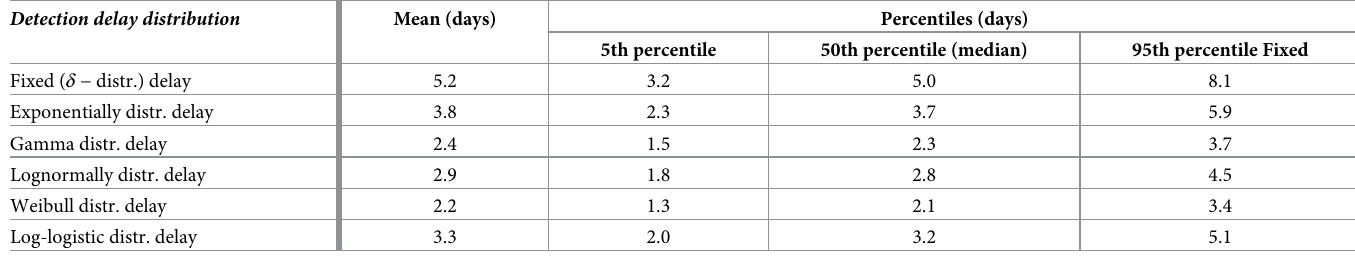
Table 4. Model-predicted mean time to successful latent cell activation, depending on detection delay distribution assumption, across study population, with 5th, 50th (median), and 95th percentiles. Detection delay